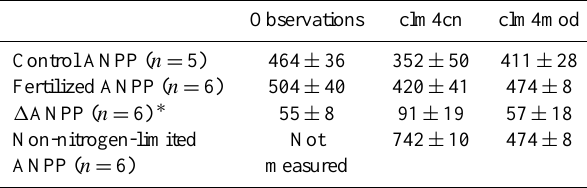
∗ The mean fertilization responses for the observations and model simulations were different than the difference between the mean control and mean fertilization ANPP because two experiments at Harvard Forest shared the same control